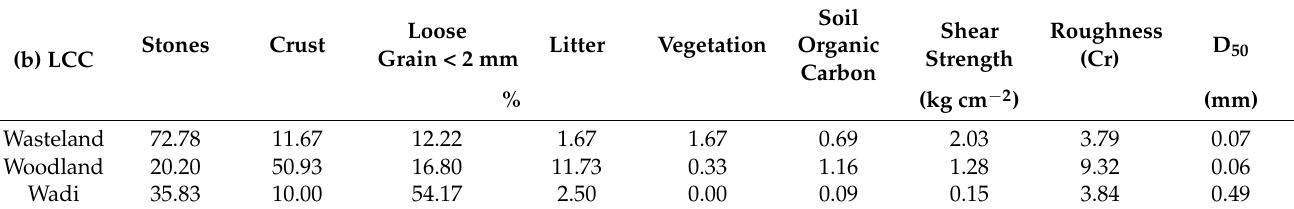
Table 3. Mean characteristics of LCC.